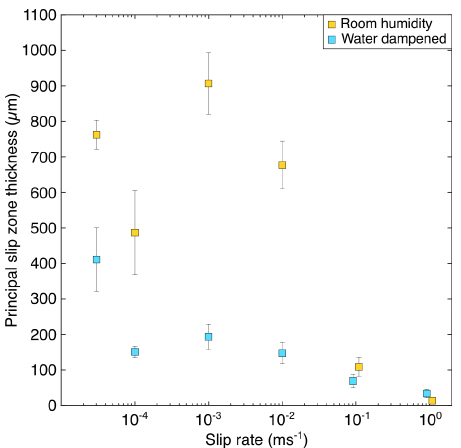
Figure 8. Slip zone thickness evolution with slip rate and presence of water. The thickness of the localised slip zone decreases almost linearly with log (V ) in water-dampened experiments. For room- humidity conditions, partial sample loss after the experiment means slip zone thickness values are a minimum